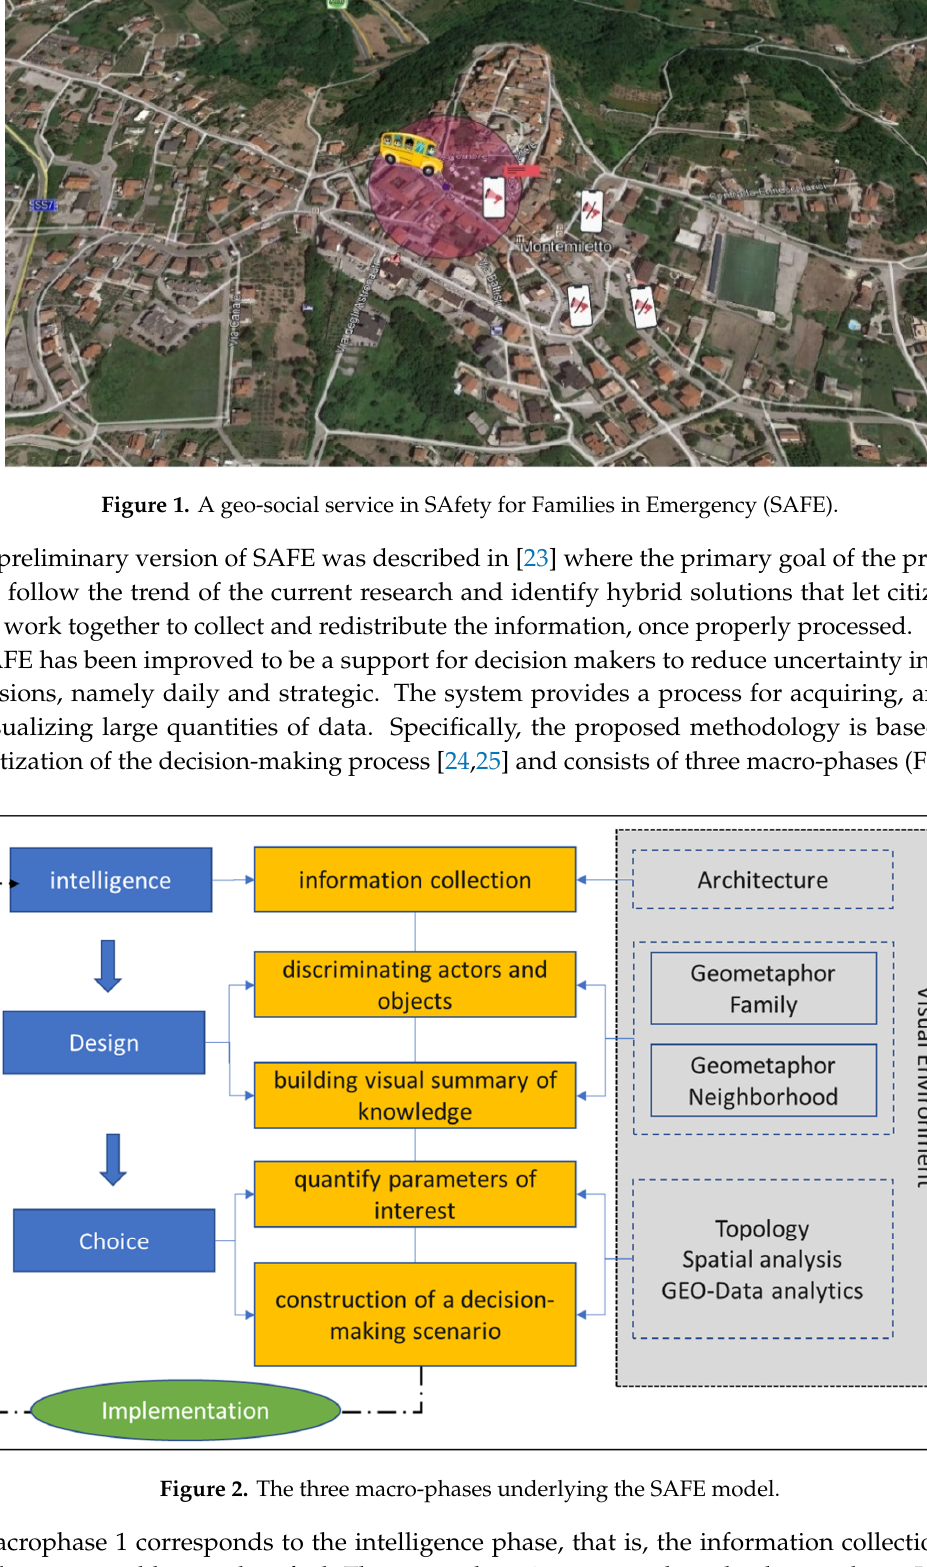
Figure 2. The three macro-phases underlying the SAFE model.